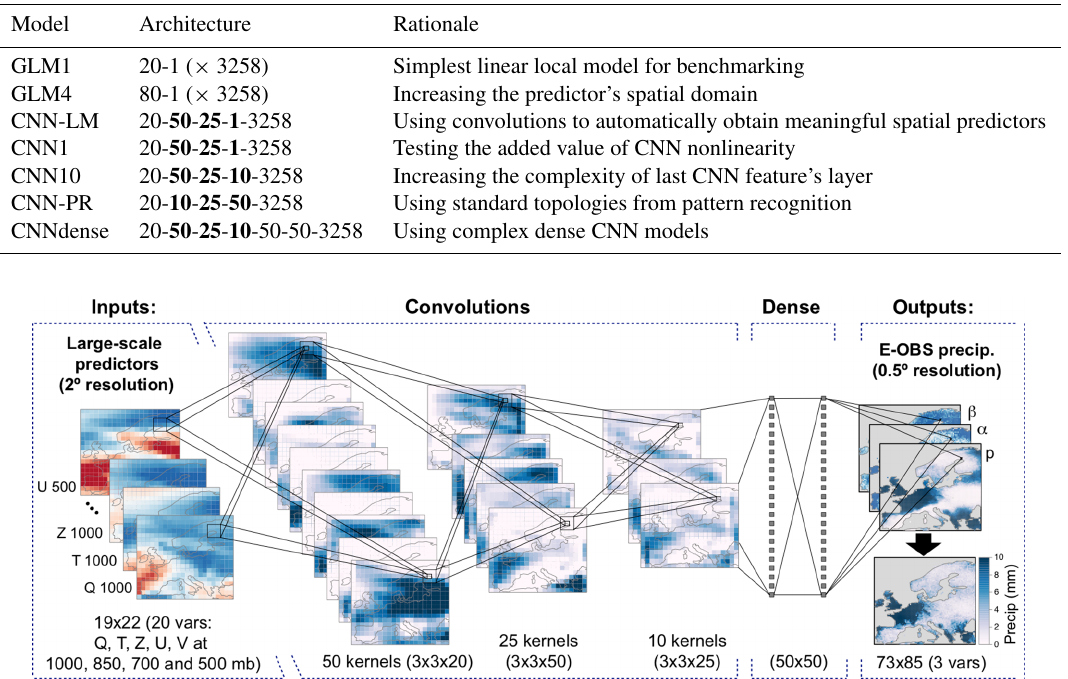
Figure 3. Scheme of the convolutional neural network architecture used in this work to downscale European (E-OBS 0 . 5 ◦ grid) precipitation based on five coarse (2 ◦ ) large-scale standard predictors (at four pressure levels). The network includes a first block of three convolutional layers with 50, 25 and 10 (3 × 3 × no. inputs) kernels, respectively, followed by two fully connected (dense) layers with 50 neurons each. The output is modeled through a mixed binomial–lognormal distribution, and the corresponding parameters are estimated by the network, obtaining precipitation as a final product, either deterministically (the expected value) or stochastically (generating a random value from the predicted distribution). The output layer is activated linearly except for the neurons associated with the parameter p , which present sigmoidal activation